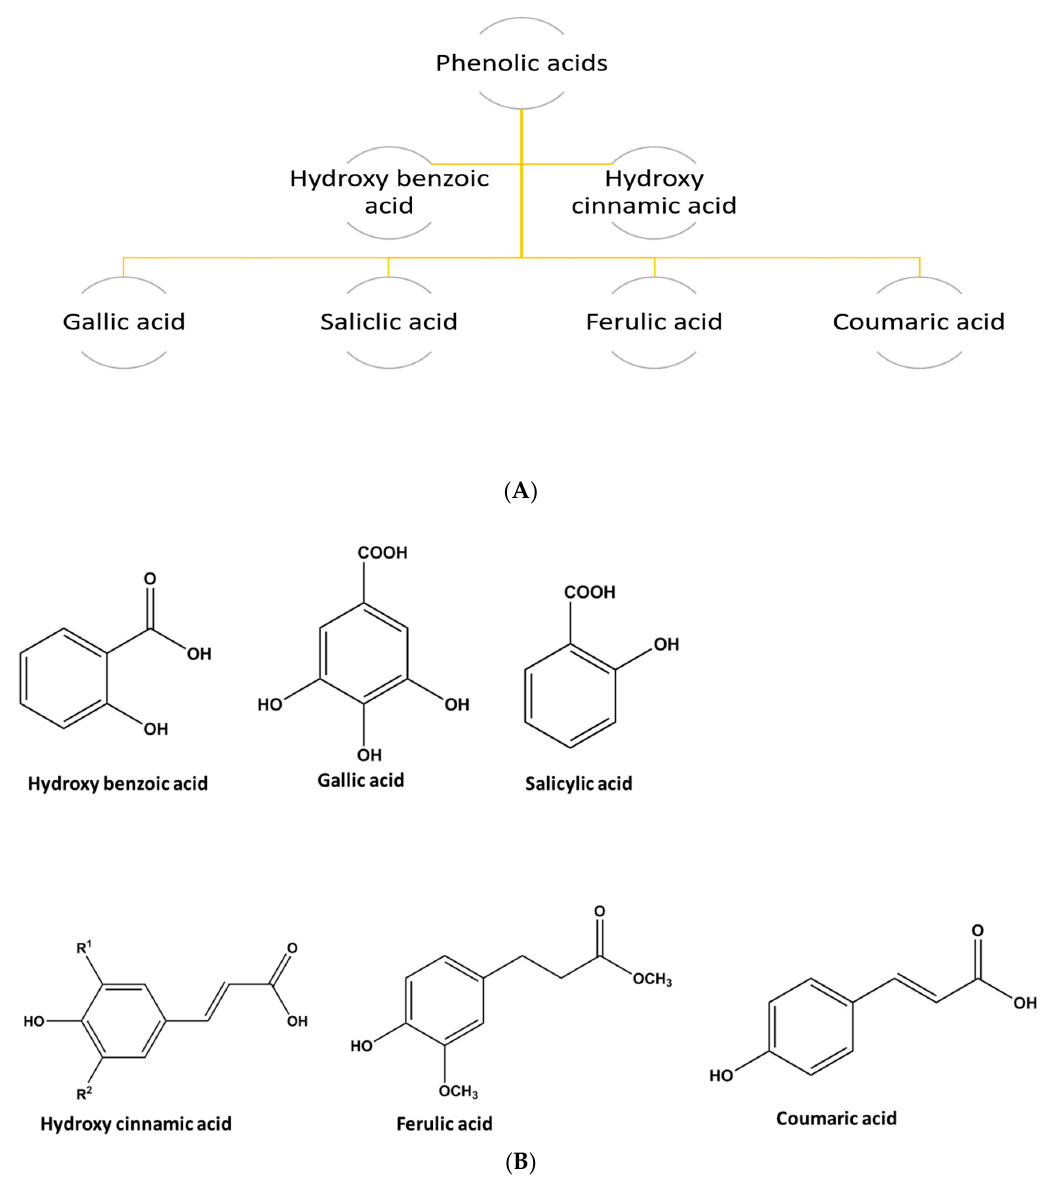
Figure 4. ( A ) Phenolic acids and their types ( B ) Common structure of some phenolic acids.